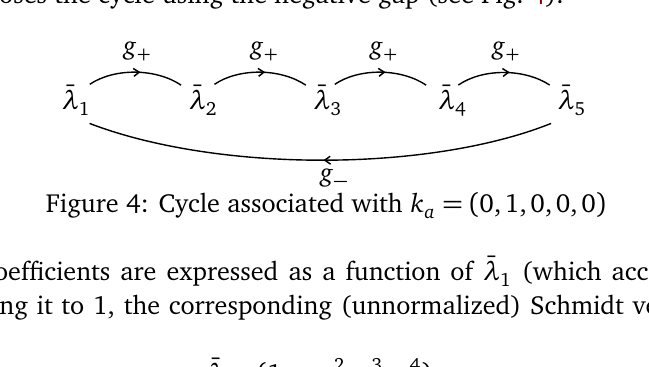
Figure 4: Cycle associated with k